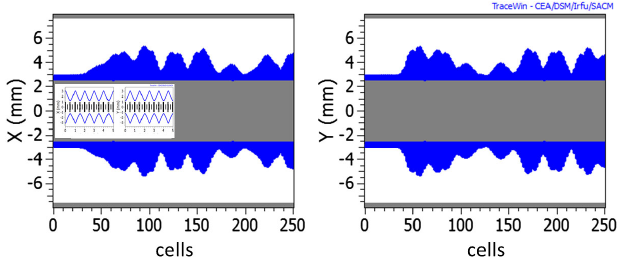
FIG. 1. Evolution of KV-envelopes versus cell number for k ¼ 100 °, k ¼ 82 °. 0 ;x;y x;y